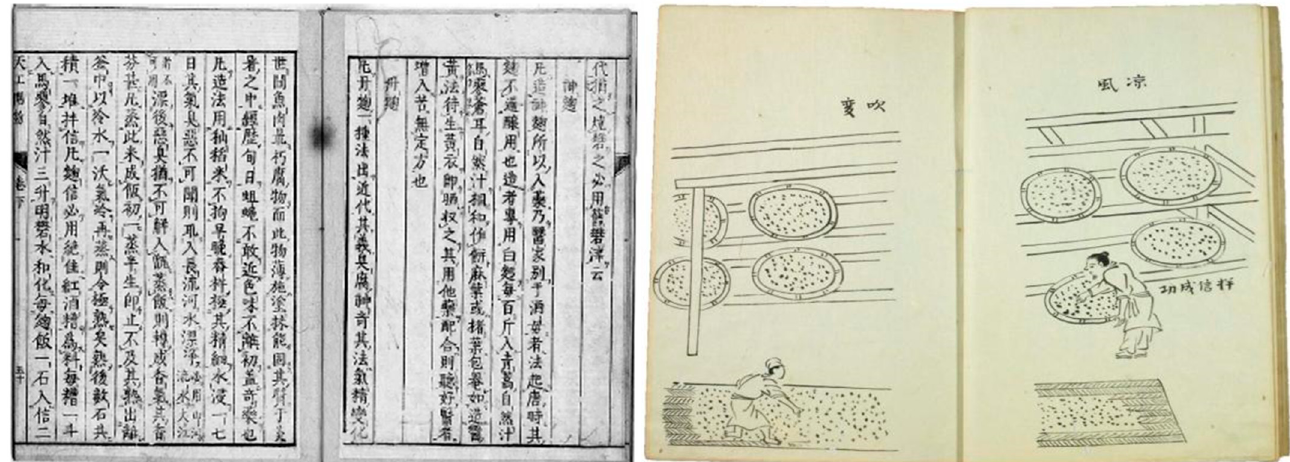
Figure 2. Production method of red yeast rice described in “ Tiangong Kaiwu ”. Rice inoculated with Monascus fungi is divided between several bamboo trays, which are placed on shelves to maintain good air circulation. Ambient air during the culture is a key factor. The room in which the shelves are placed must be wide and there must be a high ceiling. The room must also be facing south to avoid afternoon sunlight and its temperature should be controlled. Rice inoculated with the fungi should be mixed up and down 3 times every 2 hours.